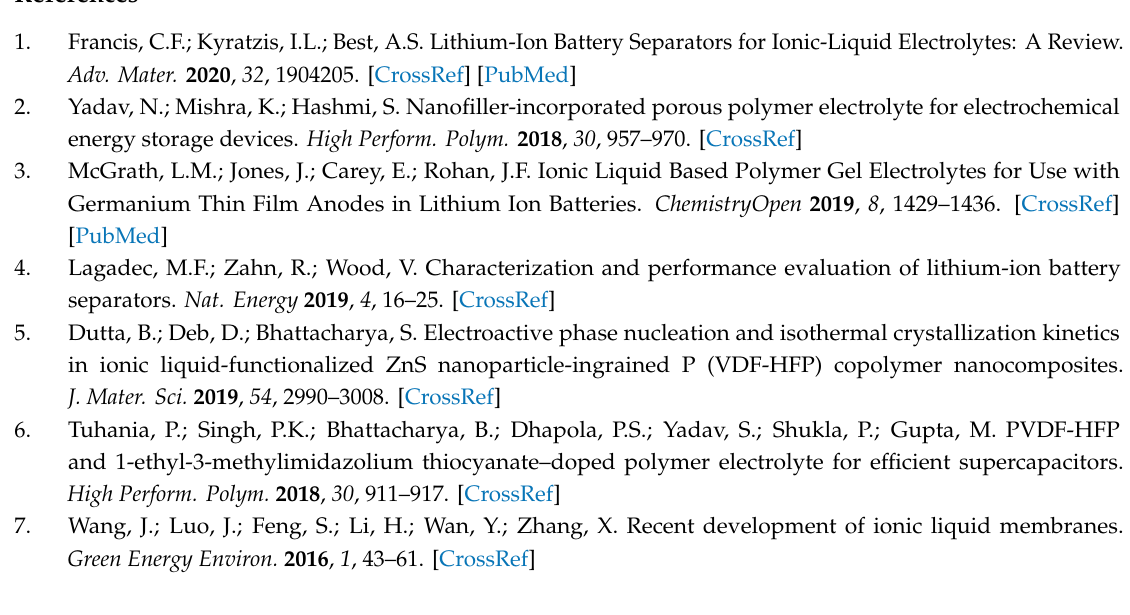
Figure S1: IR spectra of the [HMIM][NTF 2 ] / PVdF-co-HFP mixture featuring 10 wt.% of [HMIM][NTf 2 ] obtained at (a) ambient pressure and (b) 0.4, (c) 0.7, (d) 1.1, (e) 1.5, (f) 1.8, and (g) 2.5 GPa, Figure S2: IR spectra of the [EMIM][NTF2] / PVdF-co-HFP mixture featuring 10 wt.% of [EMIM][NTf2] obtained at (a) ambient pressure and (b) 0.4, (c) 0.7, (d) 1.1, (e) 1.5, (f) 1.8, and (g) 2.5 GPa, Figure S3: IR spectra of the [HMIM][NTF 2 ] / PVdF-co-HFP mixture featuring 50 wt.% of [HMIM][NTf 2 ] obtained at (a) ambient pressure, (b) 2.5 GPa, and (c) cycle back to ambient pressure, Figure S4: IR spectra of pure [EMIM][NTf 2 ] obtained at the time of (a) 5 min (100 scans), (b) 1 h (1000 scans), (c) 2 h (1000 scans), and (d) 3 h (1000 scans) after the compression under the pressure of 0.7 GPa, Figure S5: IR spectra of pure [EMIM][NTf 2 ] (pre-heated to 155 ◦ C) obtained at (a) ambient pressure and (b) 0.4, (c) 0.7, (d) 1.1, (e) 1.5, (f) 1.8, and (g) 2.5 GPa at 25 ◦